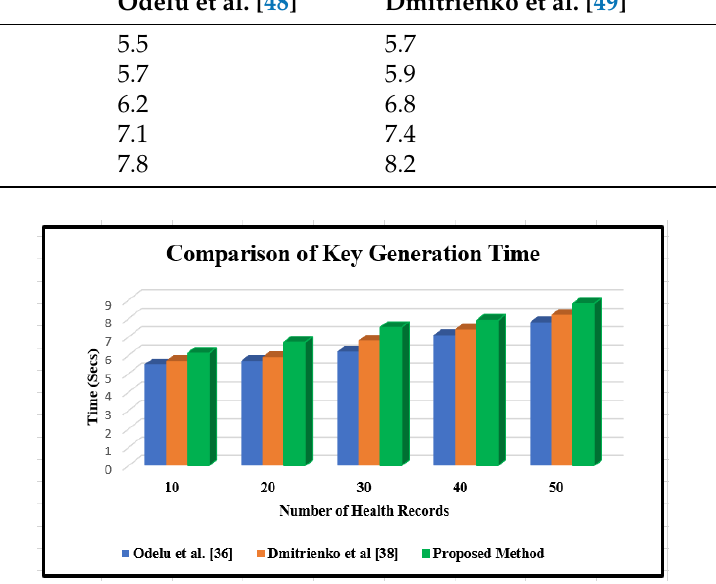
Figure 12. Comparison of key generation time in IoT environment.